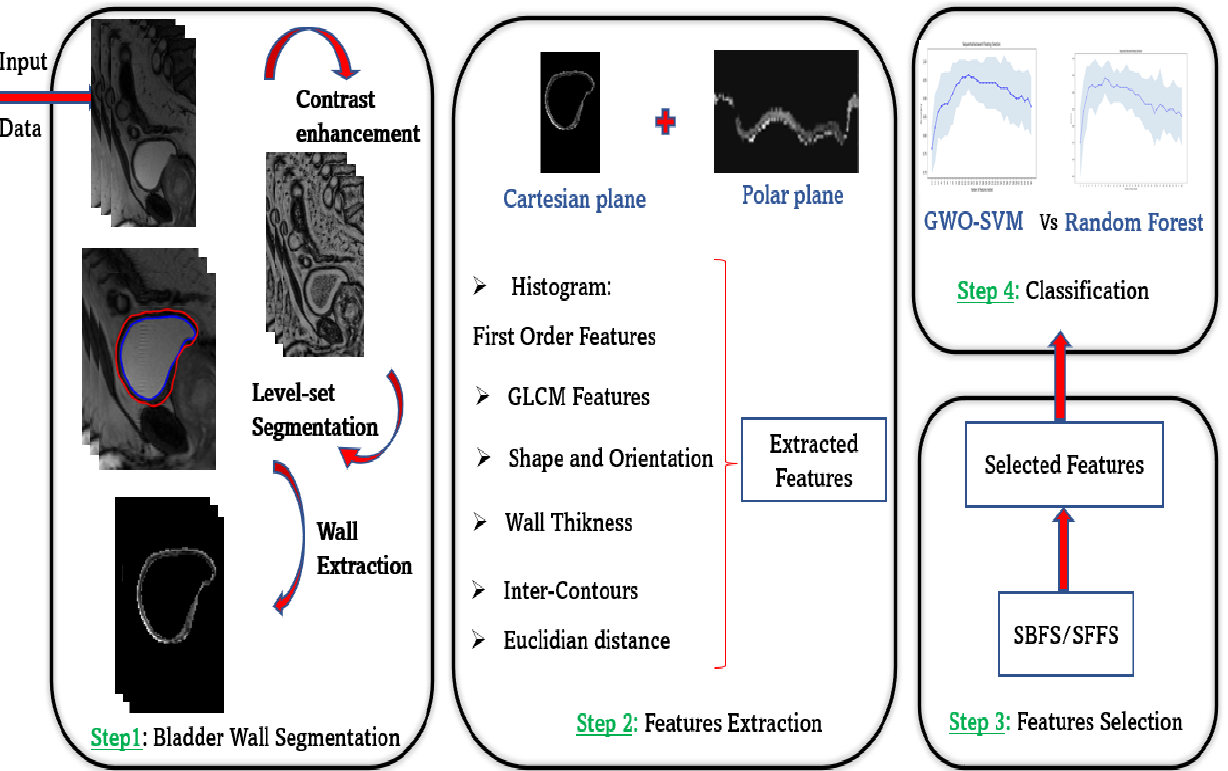
Figure 1. Overview workflow of our bladder wall characterization strategy.